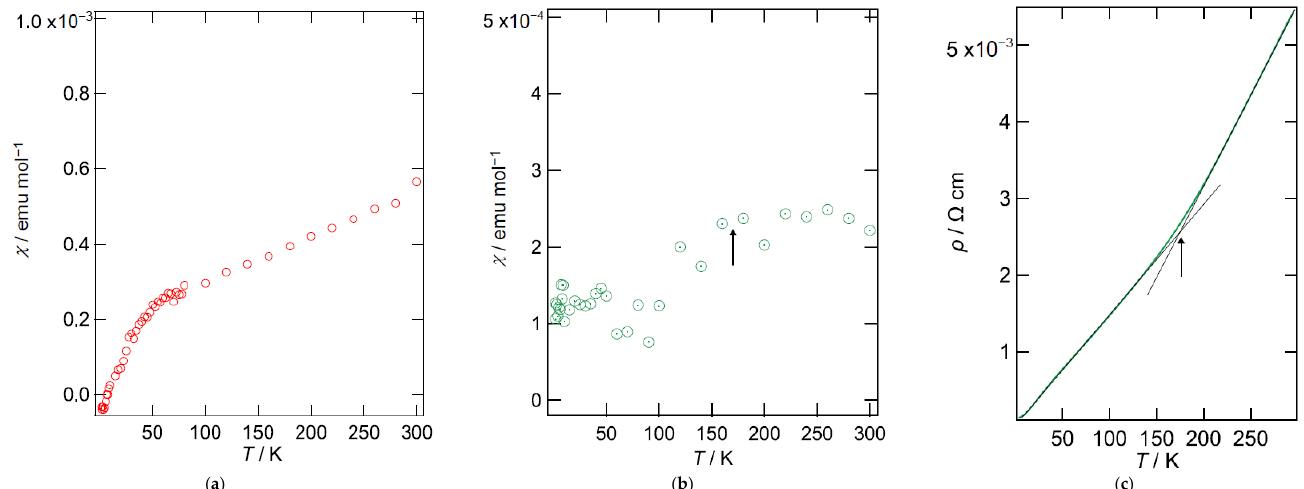
Figure 5. Temperature dependences of magnetic susceptibilities of ( a ) 1 and ( b ) 3 , where 0.46 and 0.30% of Curie tails have been subtracted, respectively. ( c ) Resistivity–temperature plots of 3